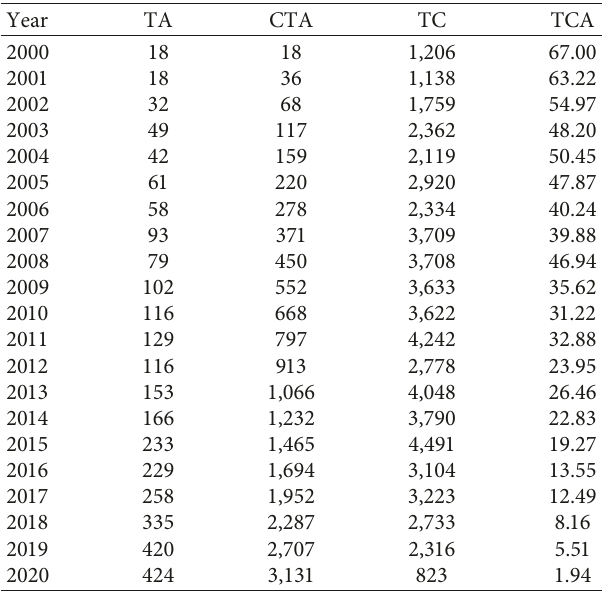
Table 1: The publication and citation